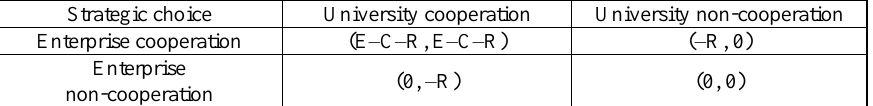
Table 1. Game profit matrix between enterprises and local universities.